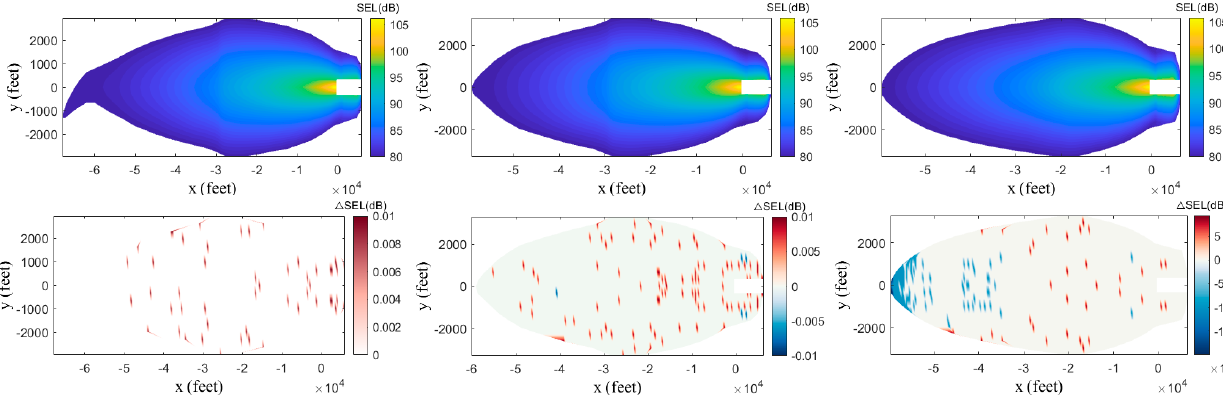
Figure 7. Reference measurement points in noise certification tests. Table 2. Noise levels for B737-800 and A320-211 aircraft at three certification points, as measured and calculated (in EPNdB) with associated errors (in percentage). Approach